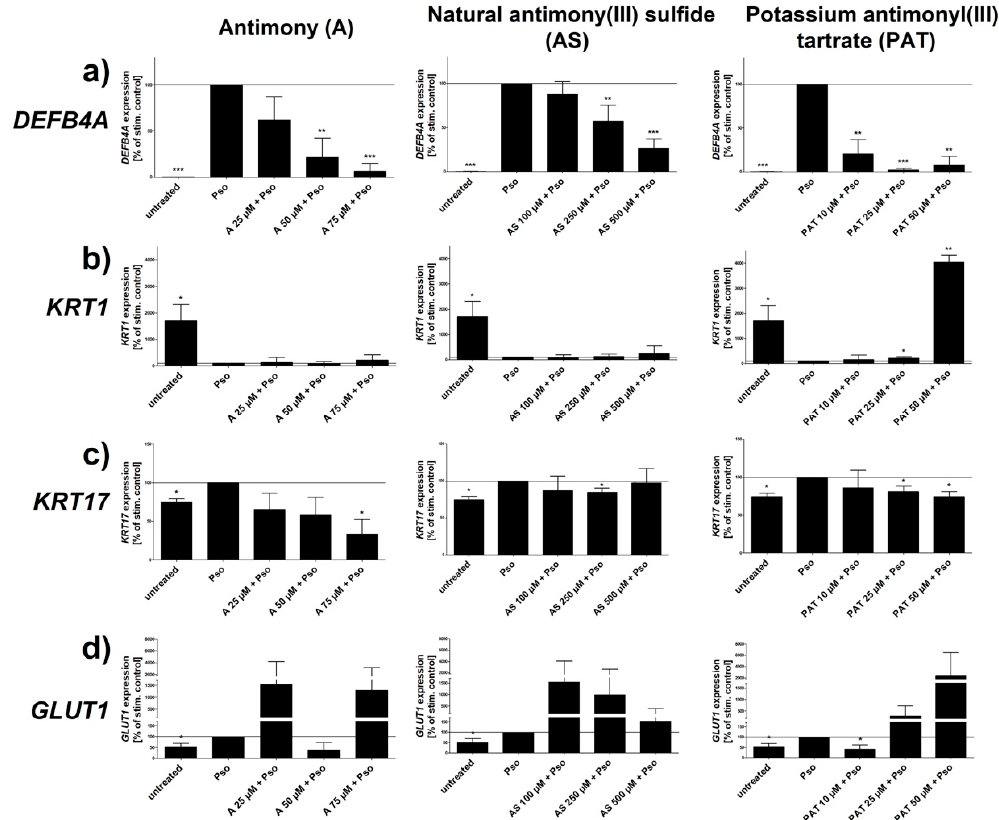
Figure 2. Effect of ACs on Pso-induced gene expression. PHKs were stimulated with Pso (20 ng/mL of IL-17A, IL-22 and TNF- α ) for 24 h with or without a pre-treatment of increasing concentrations of A, AS or PAT. ( a ) DEFB4A ; ( b ) KRT1 ; ( c ) KRT17 and ( d ) GLUT1 mRNA expression was analyzed by real-time qRT-PCR with ACTB as reference gene for the analysis using the comparative C T method [27]. Values were then normalized setting the Pso-treated PHKs as 100% expression. Results are shown as mean ± SD of three independent experiments. Statistical analysis was performed using column statistics with one-sample t -test comparing the samples to Pso stimulation. * p ≤ 0.05, ** p ≤ 0.01, *** p ≤ 0.001.